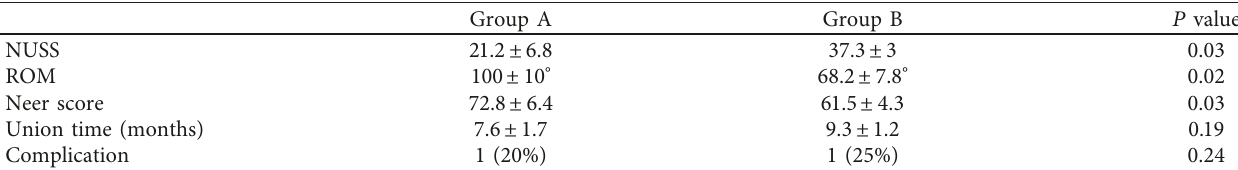
Table 2: Clinical and radiological outcomes at last follow-up according to the surgical